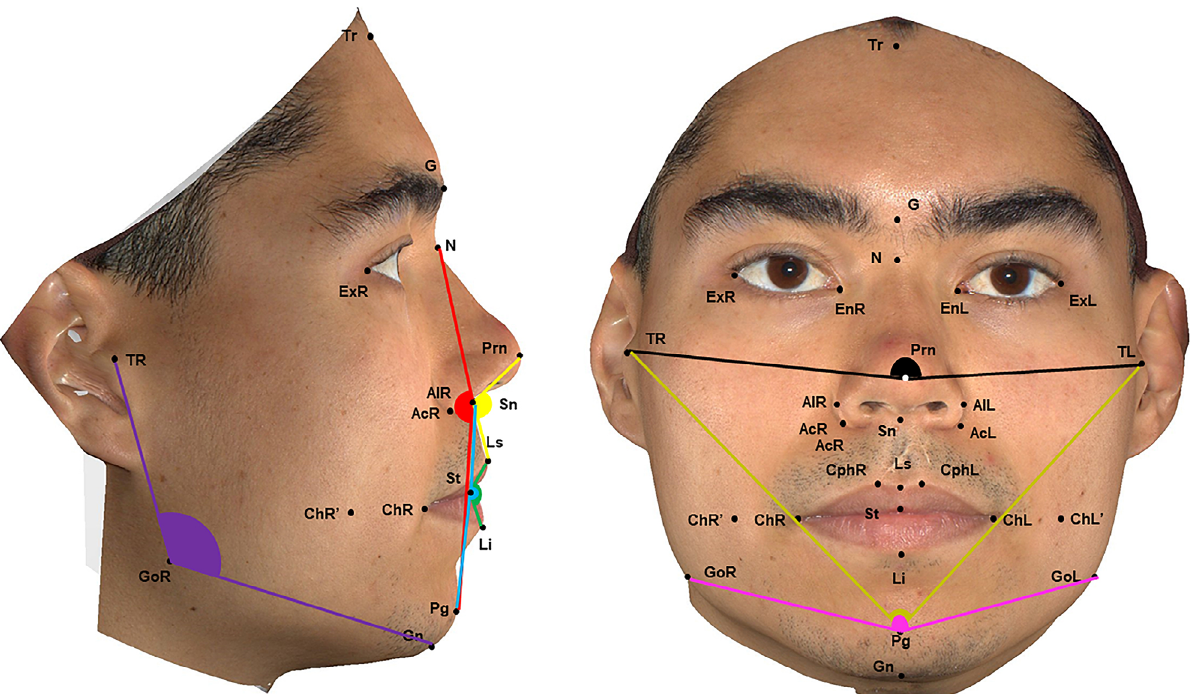
Figure 3- Angular measures obtained with the Vectra Analysis Module software (VAM elaboration, Canfield Scientific Inc.). Purple: right gonial angle; red: facial convexity (excluding nose); yellow: nasolabial angle; green: sealed lip angle; blue: lower facial convexity; black: middle facial convexity; gold: lower facial convexity; pink: mandibular